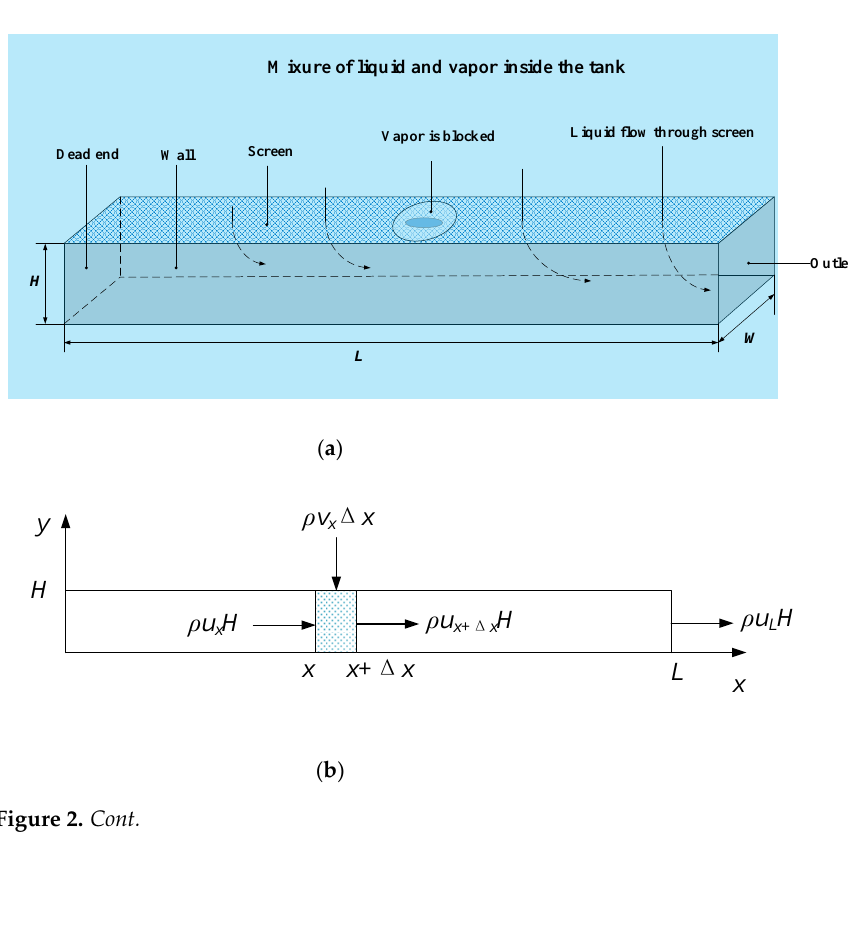
Figure 1. Schematic diagram of a typical screen channel LAD.